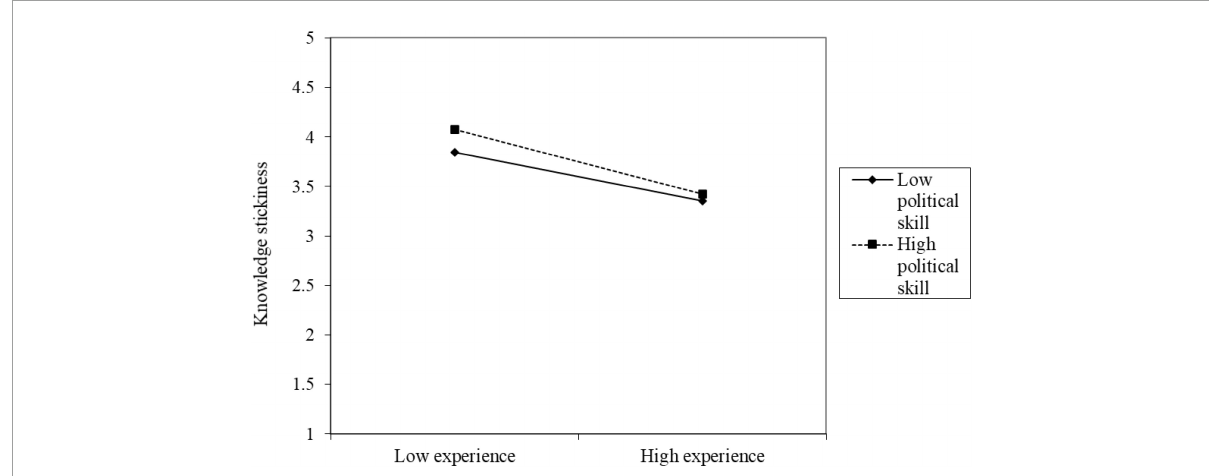
FIGURE2 Diagram of the interaction of political skills affecting experience on knowledge stickiness.